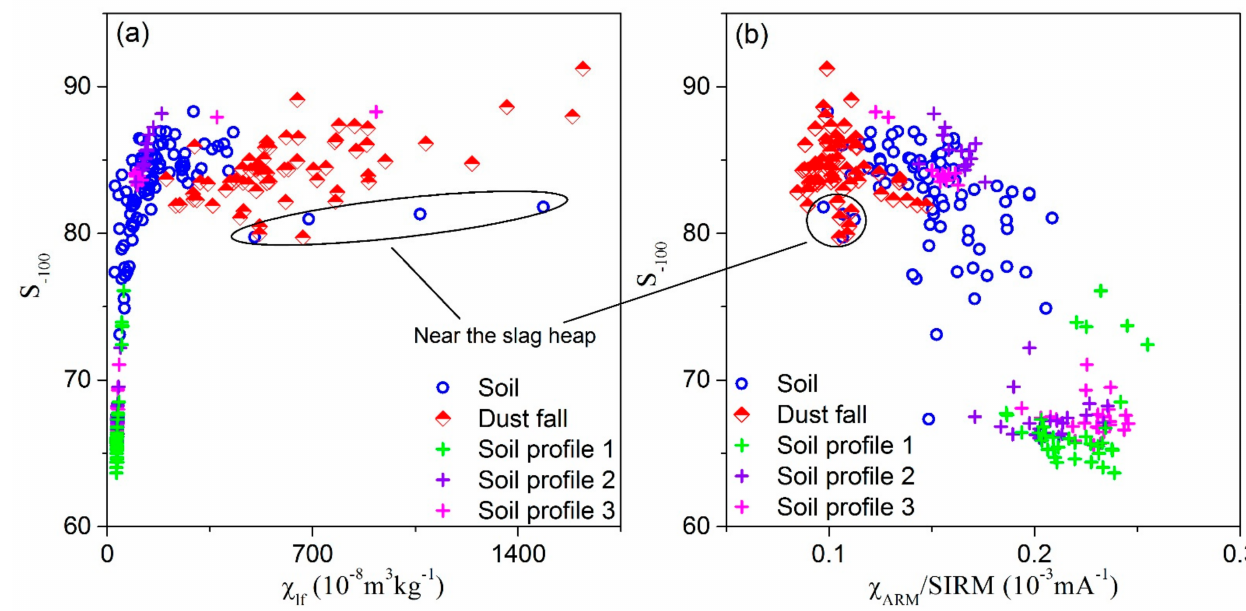
Figure 8. Scatter plot of ( a ) χ lf versus S − 100 and ( b ) χ ARM /SIRM versus S − 100 .